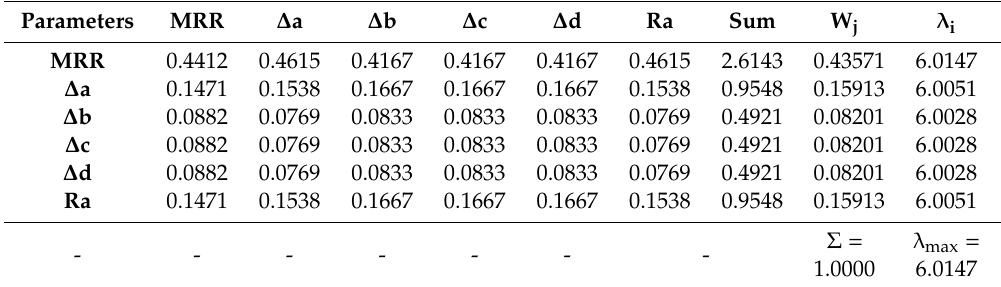
Table 5. Steps 3 and 4 of the approximation Analytic Hierarchy Process (AHP) methodology for determining weight coe ffi